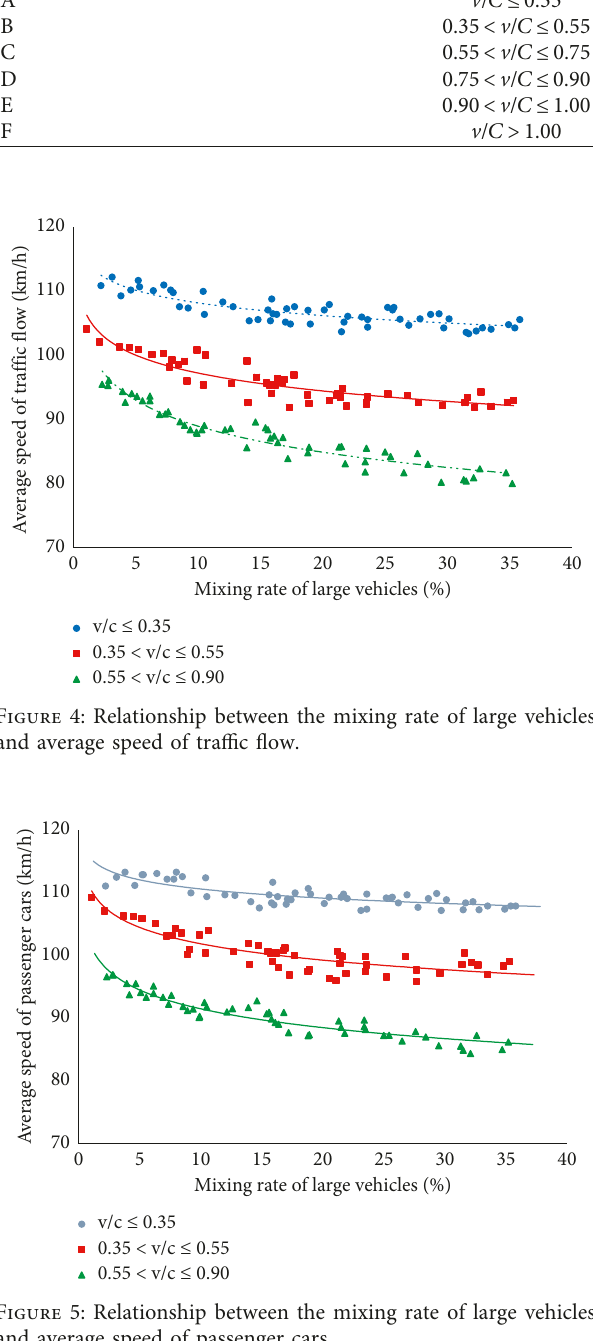
Table 2: Level of service for basic expressway segments. Level of service